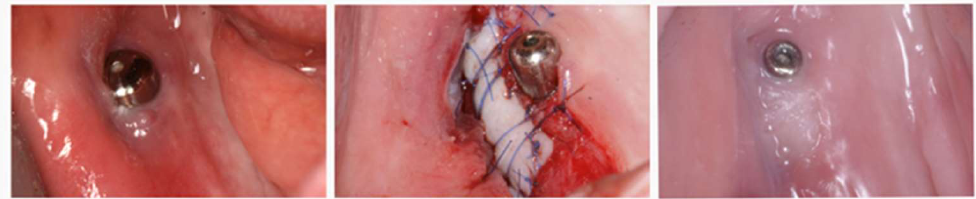
Figure 3. Patient no. 5 requiring revision surgery due to buccal impaction of the healing abutment ( left ); free gingival graft surgery ( middle ); postoperative healing ( right ).